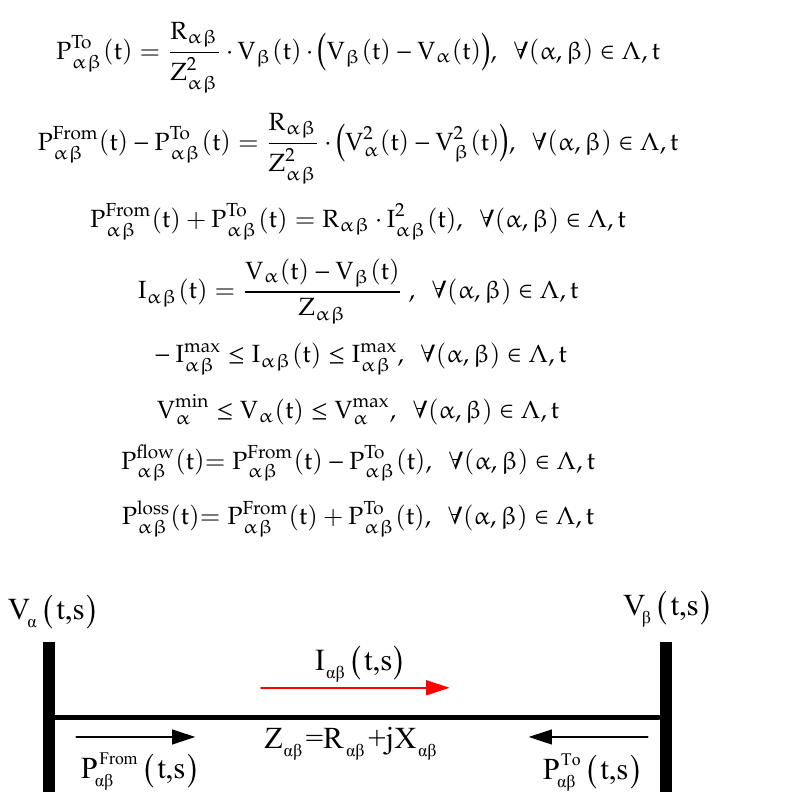
Figure 2. A typical branch of the Smart Distribution Networks (SDN).